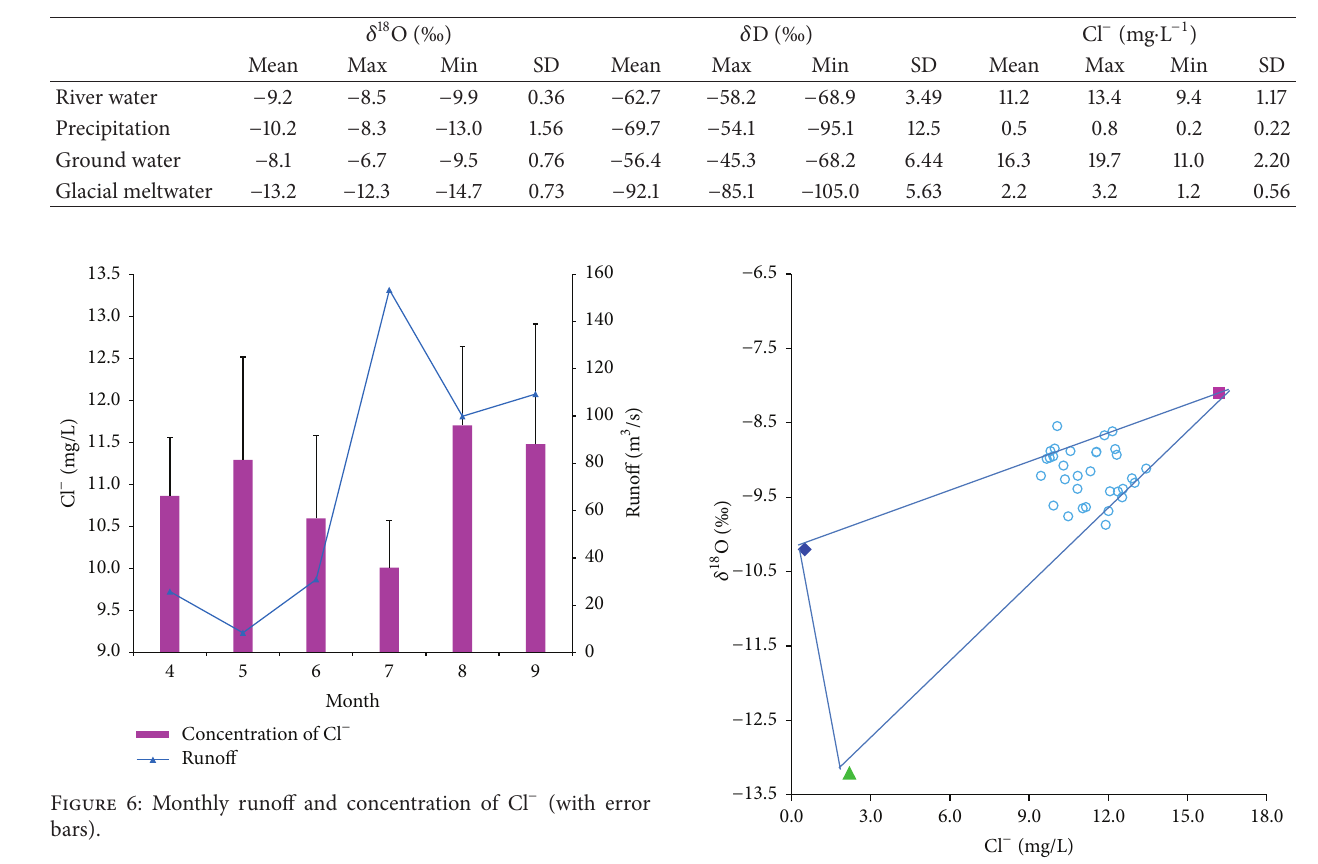
Table 1: Mean, maximum, minimum, and standard deviation values for the concentration of isotope and chloride ion in river water, precipitation, groundwater, and glacial meltwater.